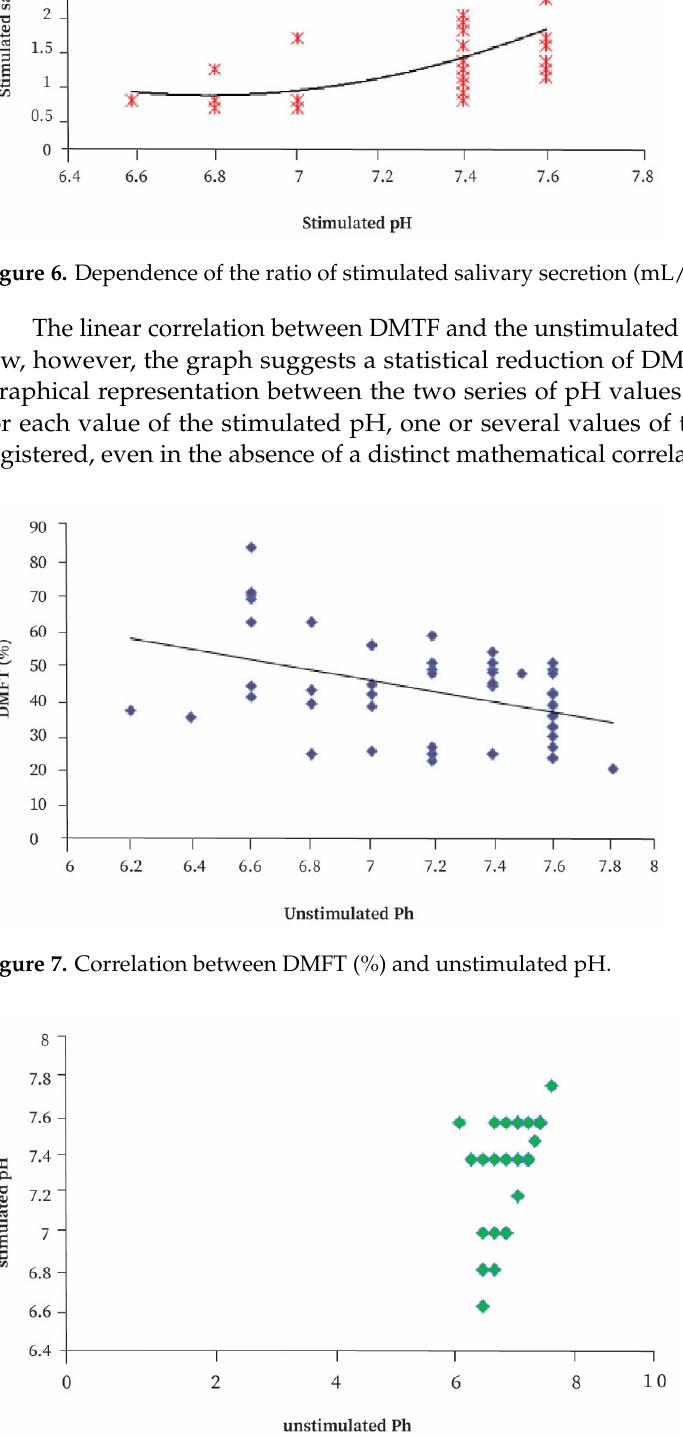
Figure 8. Correlation between stimulated and unstimulated pH.